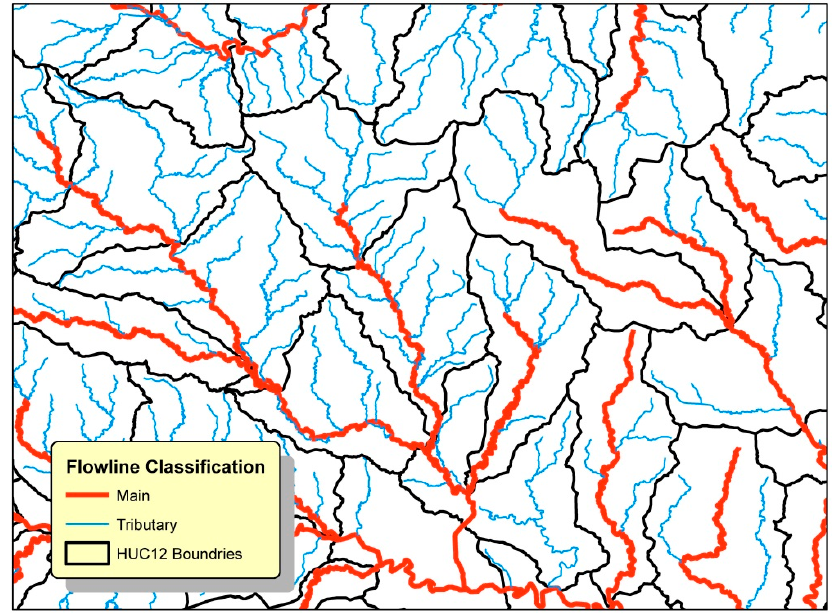
Figure 2. National Hydrography Dataset Plus (NHDPlus) V2 streams attributed with main or tributary status.